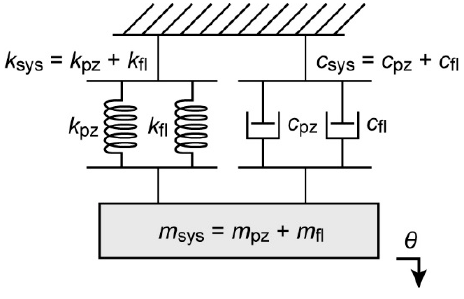
Figure 5. System block diagram.